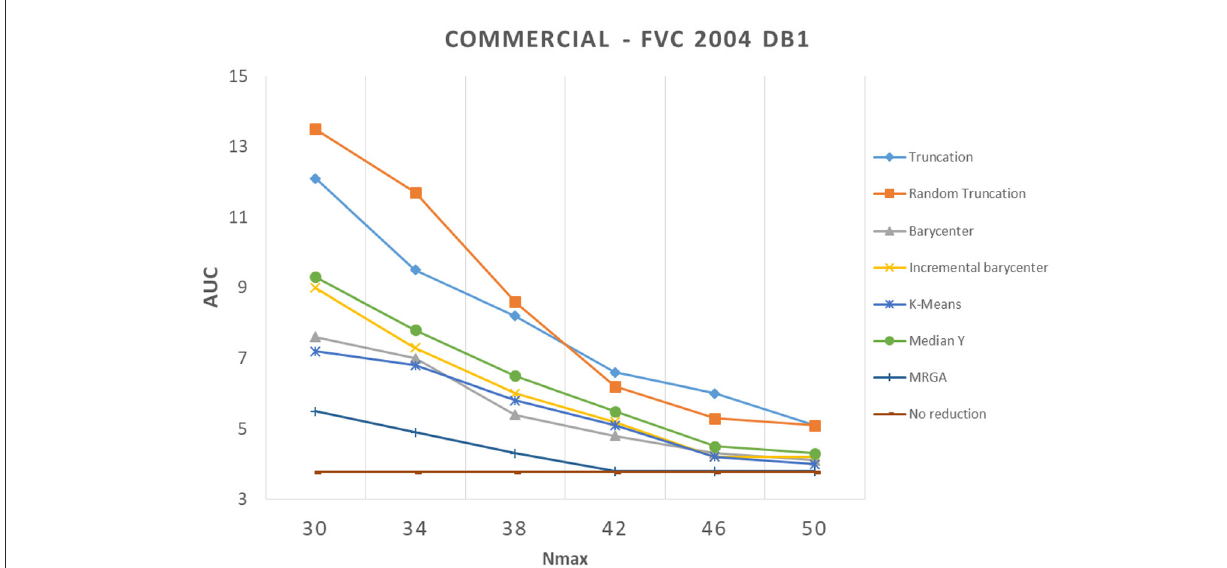
FIGURE5 Comparison of template reduction methods on the FVC 2004 DB1 with the commercial matching algorithm.